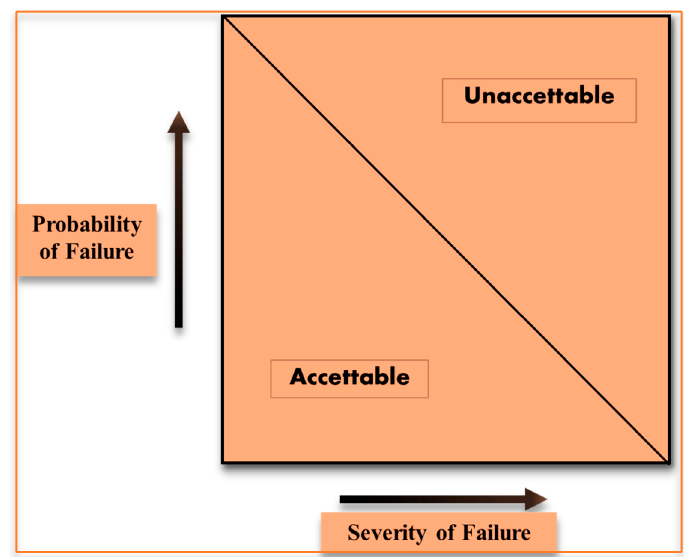
Figure 7. Relationship between probability and severity of failure condition effects, (adapted from [24]).